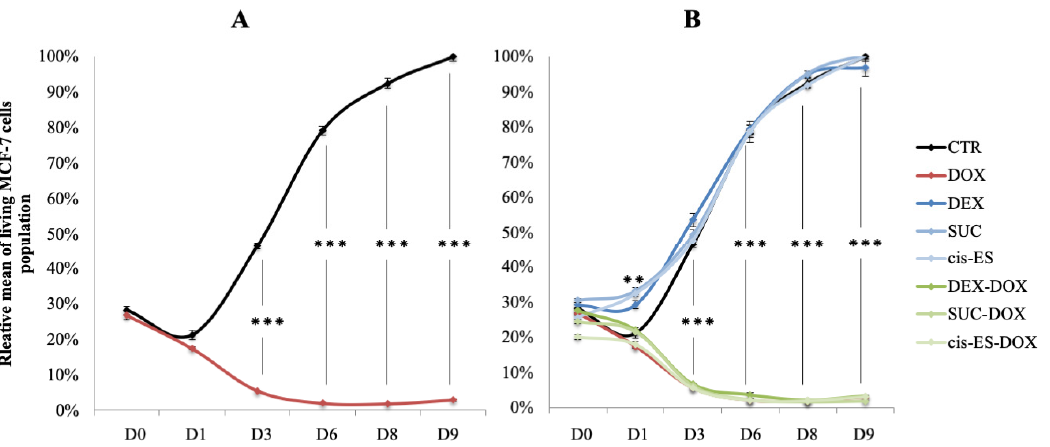
Figure 7. Relative mean ( +/ − SEM) of living MCF-7 cells population after day 0, 1, 3, 6, 8 and 9 of the first exposure to DOX, and cardioprotective compounds administrated alone or 30 min prior to DOX exposure. ( A ) Proliferation curves from the CTR and DOX-exposed cells. ( B ) Proliferation curves from the CTR, DOX-exposed and protective compound-exposed cells. Student’s t -test: ** p -value < 0.01 and *** p -value <